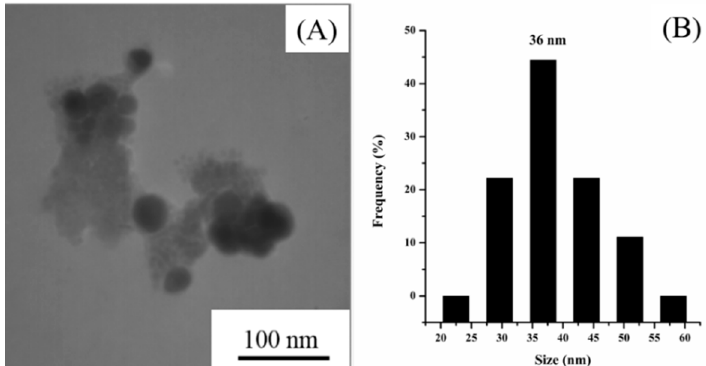
Figure 2. ( A ) Image and ( B ) size distribution diagram of epirubicin-capped silver nanoparticles (NPs).